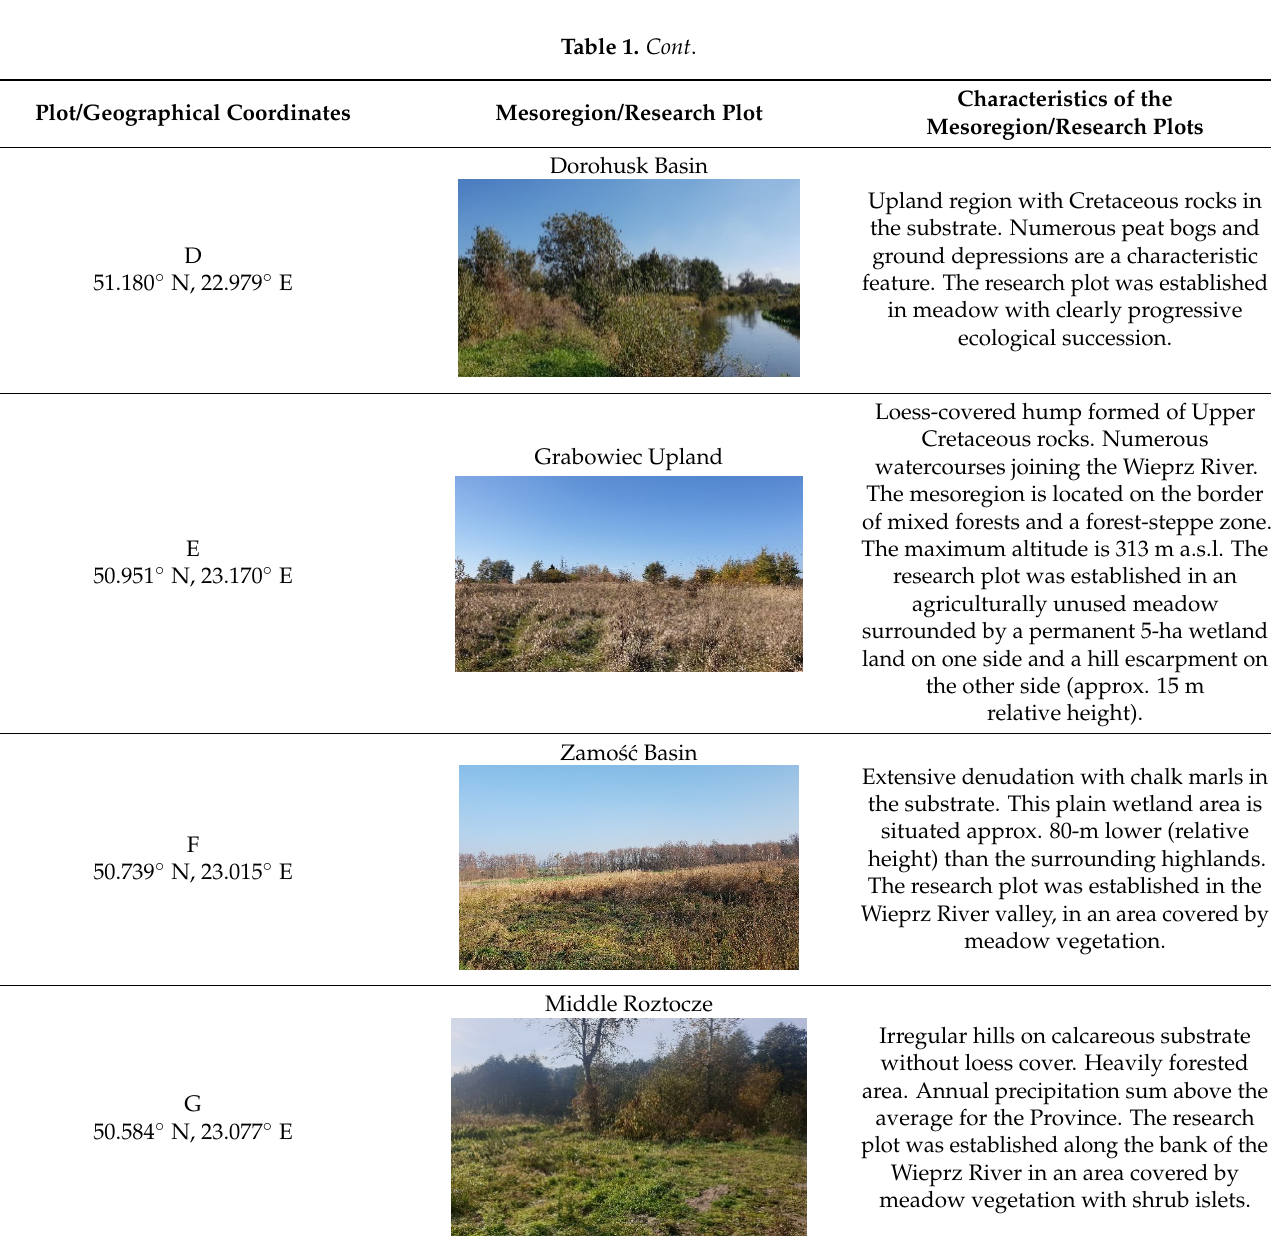
Irregular hills on calcareous